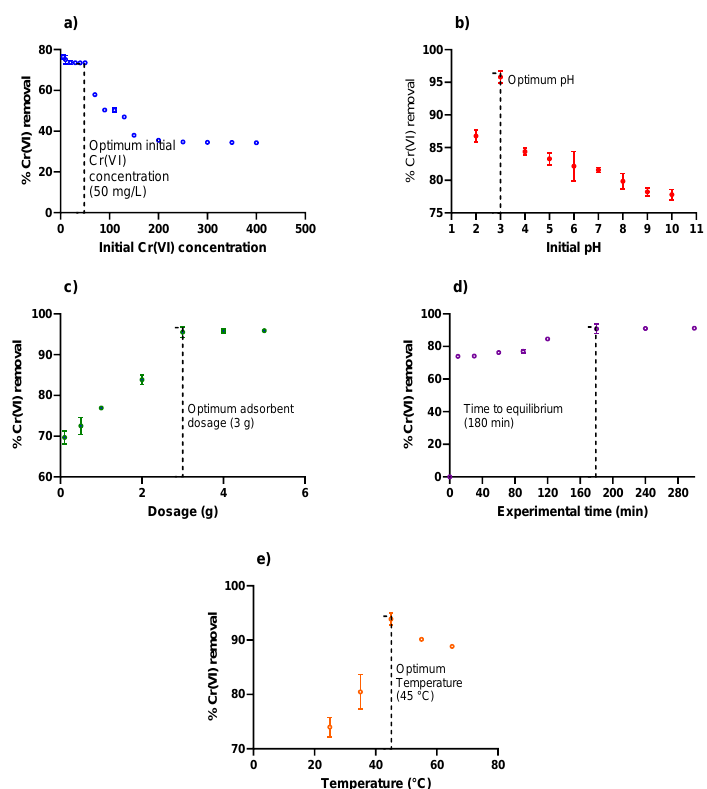
Figure 10. Effects of different operational parameters on the adsorption of Cr(VI), where ( a ) shows % Cr(VI) removal versus initial Cr(IV) concentration; ( b ) shows % Cr(VI) versus initial pH; ( c ) shows % Cr(VI) removal versus dosage; ( d ) shows % Cr(VI) removal versus agitation time; and ( e ) shows % Cr(VI) removal versus temperature.